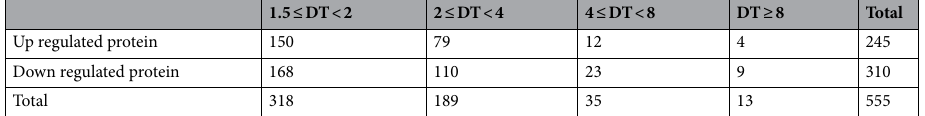
Table 2. The number of differentially expressed proteins in tobacco roots after different multiplus (DT) of growing seedlings in high potassium medium, compared with growing seedlings in low potassium control